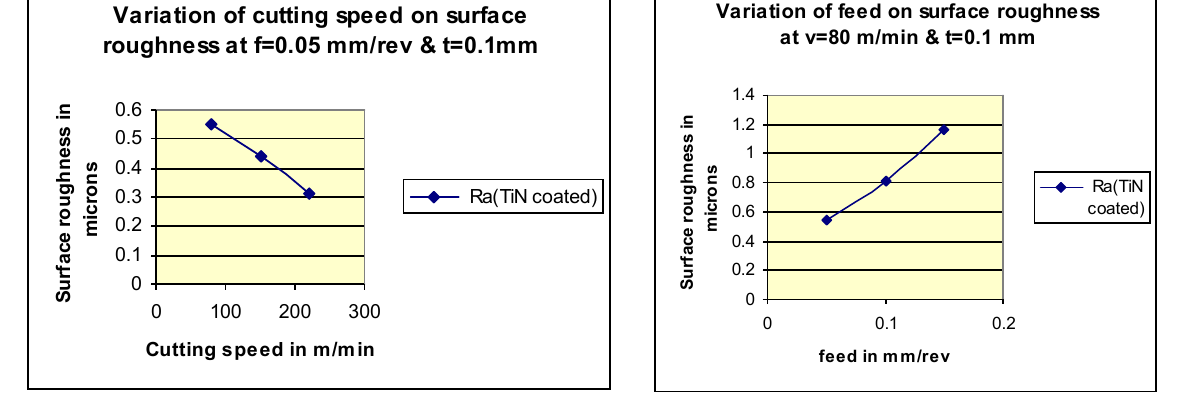
Fig. 4. Cutting speed vs. surface roughness Fig. 5. Feed vs. surface roughness